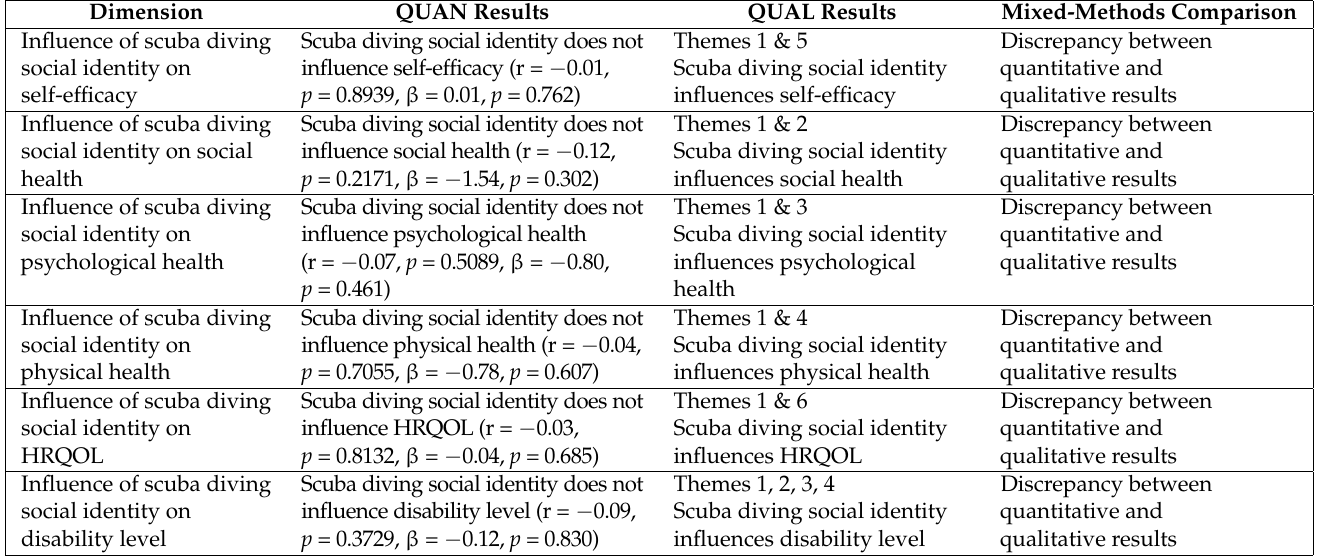
Table 8. Comparison of quantitative and qualitative results.